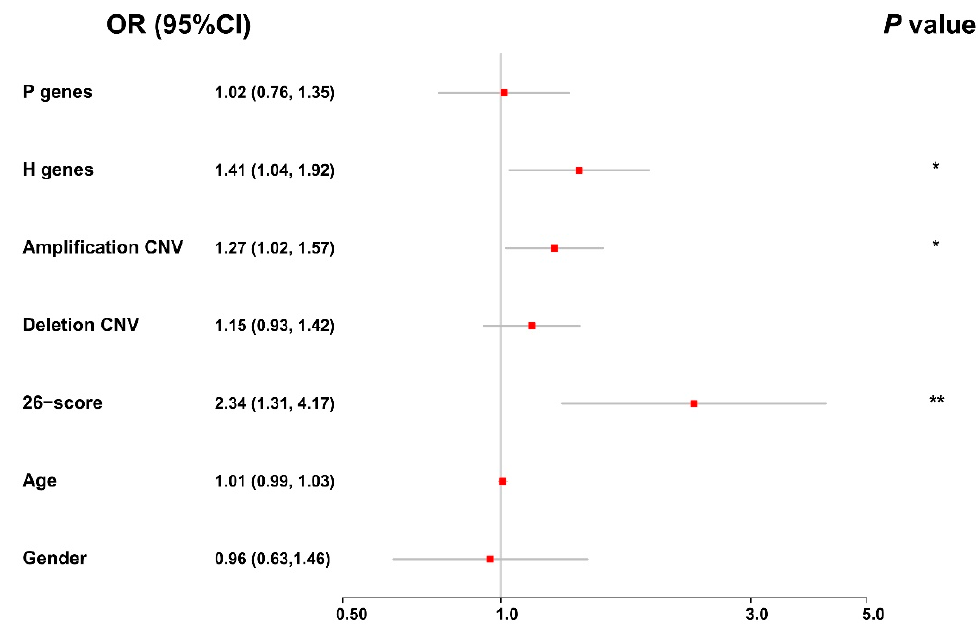
Figure 8. The forest plot for the ordinal logistic regression result in the integrative analysis. The red box and grey line represent the odds ratio (OR) and the corresponding 95% confidence interval, respectively, and the asterisks mark the statistically significant variables. * p -value < 0.05; ** p -value < 0.01.